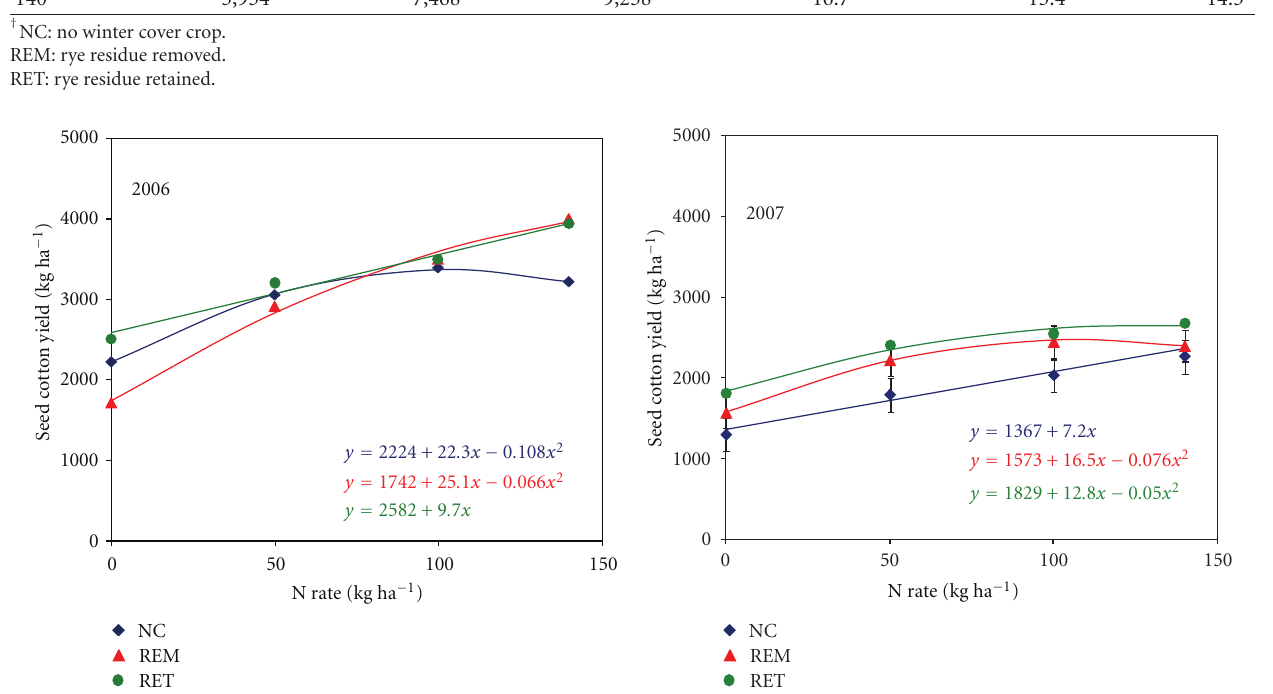
Figure 9: Seed cotton yield as a ff ected by rye residue management and N rate, for the 2006 and 2007 seasons. NC: no winter cover crop; REM: rye residue removed; RET: rye residue